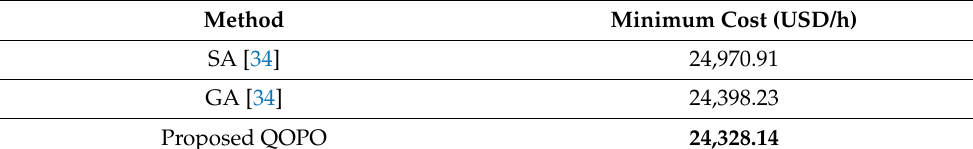
Table 6. Comparison of results of 13-unit system for the load demand of 2520 MW.